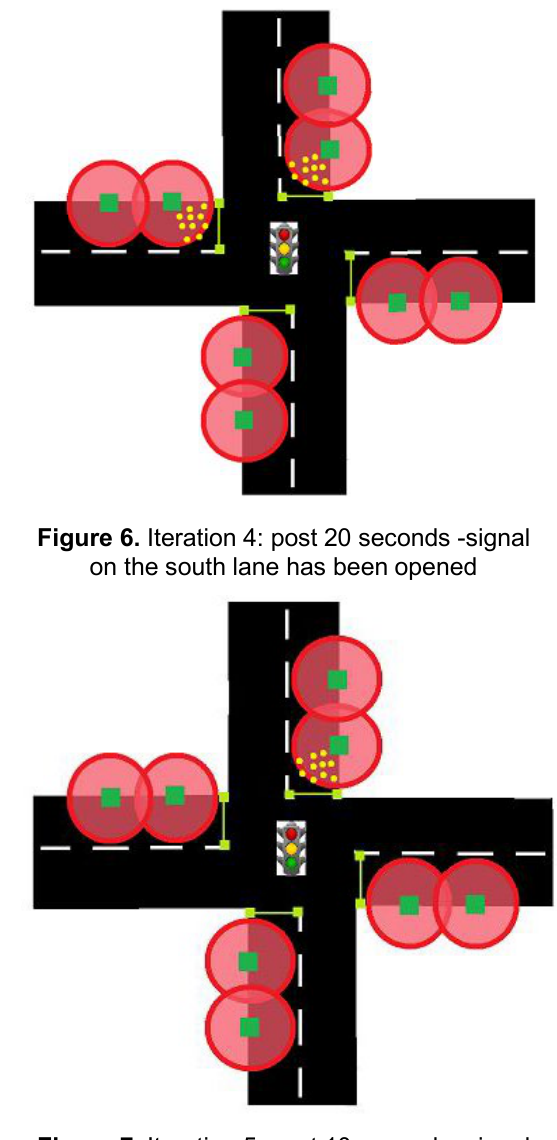
Figure 7. Iteration 5: post 10 seconds